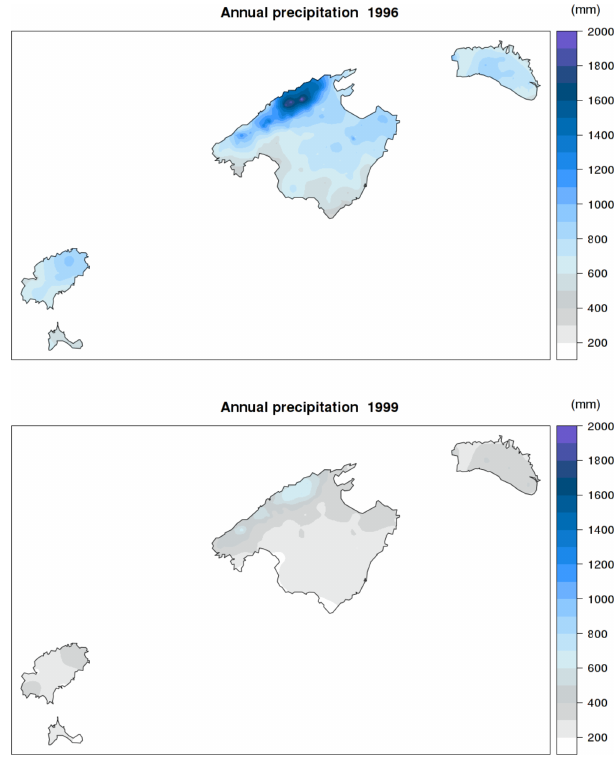
Figure 3. Spatial distribution of accumulated precipitation for 1996 (wet year) and 1999 (dry year). The same scale is used (from http: